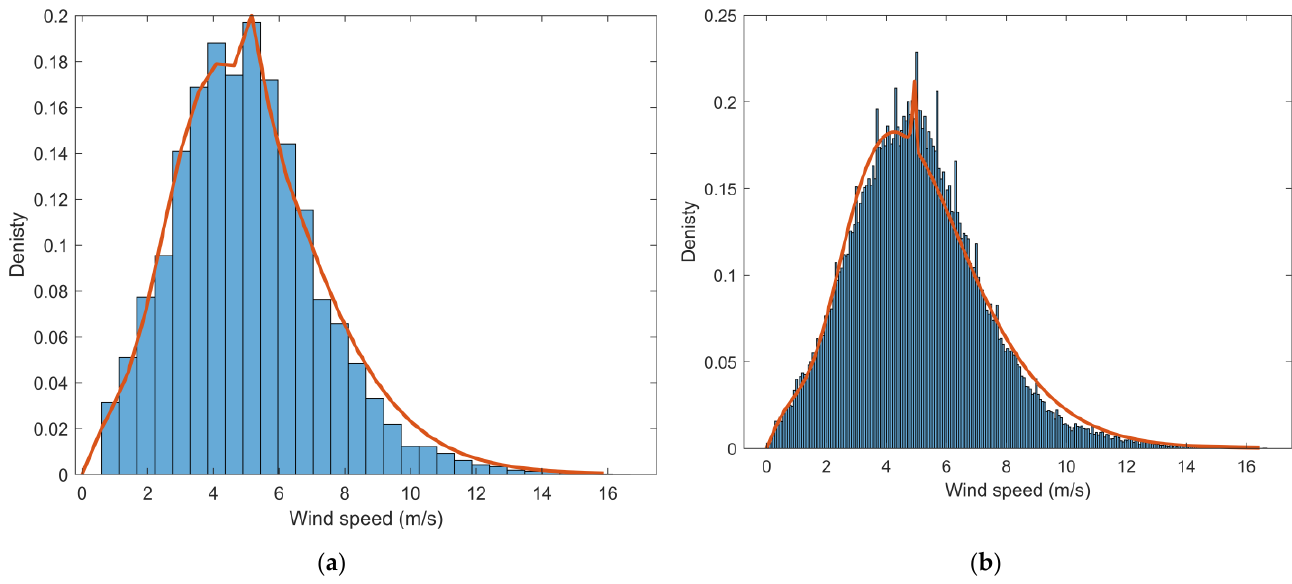
Figure 4. Fitting wind data of Site 2 to 𝑓 𝑚𝑖𝑥 using MOPSO: ( a ) 30 equal wind speed spacings; ( b ) variable wind speed spacings.